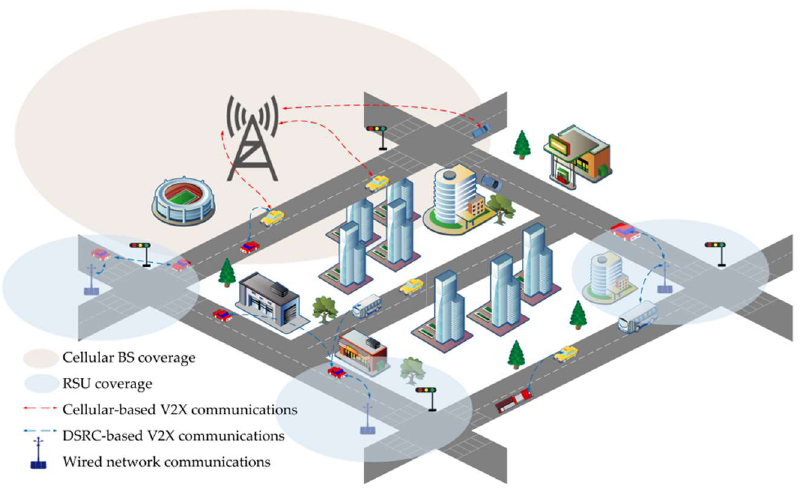
Figure 7. V2X communication in a DSRC–cellular hybrid urban scenario.